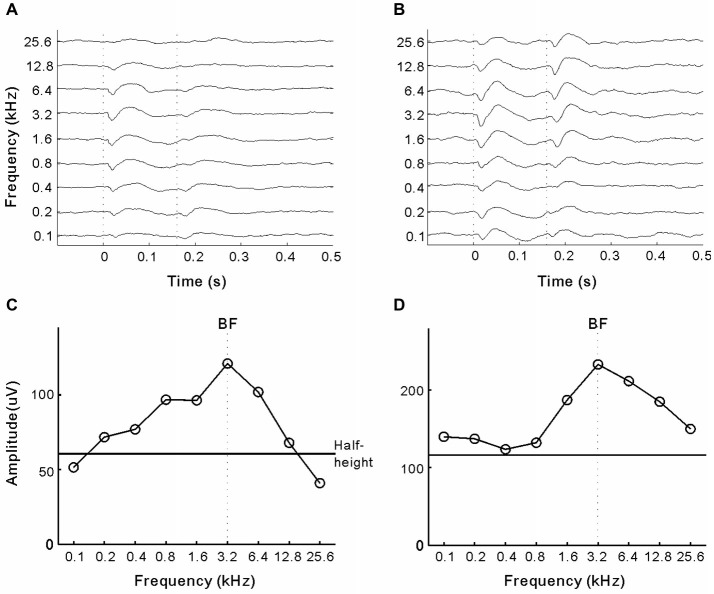
LFPs of two example sites. (A,B) LFPs driven by pure-tone stimuli in the A1 and A2 sites, respectively. Each line represents a local field potential (LFP) averaged across 10 repetitions of one tonal frequency. Vertical lines mark the onset and offset of sound stimuli. (C,D) The amplitude of LFP (peak-to-peak value) against tonal frequency. Vertical line marks the best frequency (BF), at which LFP reaches the maximum amplitude. Horizontal line marks the height of half-maximum amplitude.